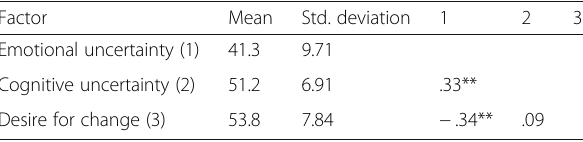
Table 2 URS — mean, standard deviation, and correlations between factors (EFA — sample